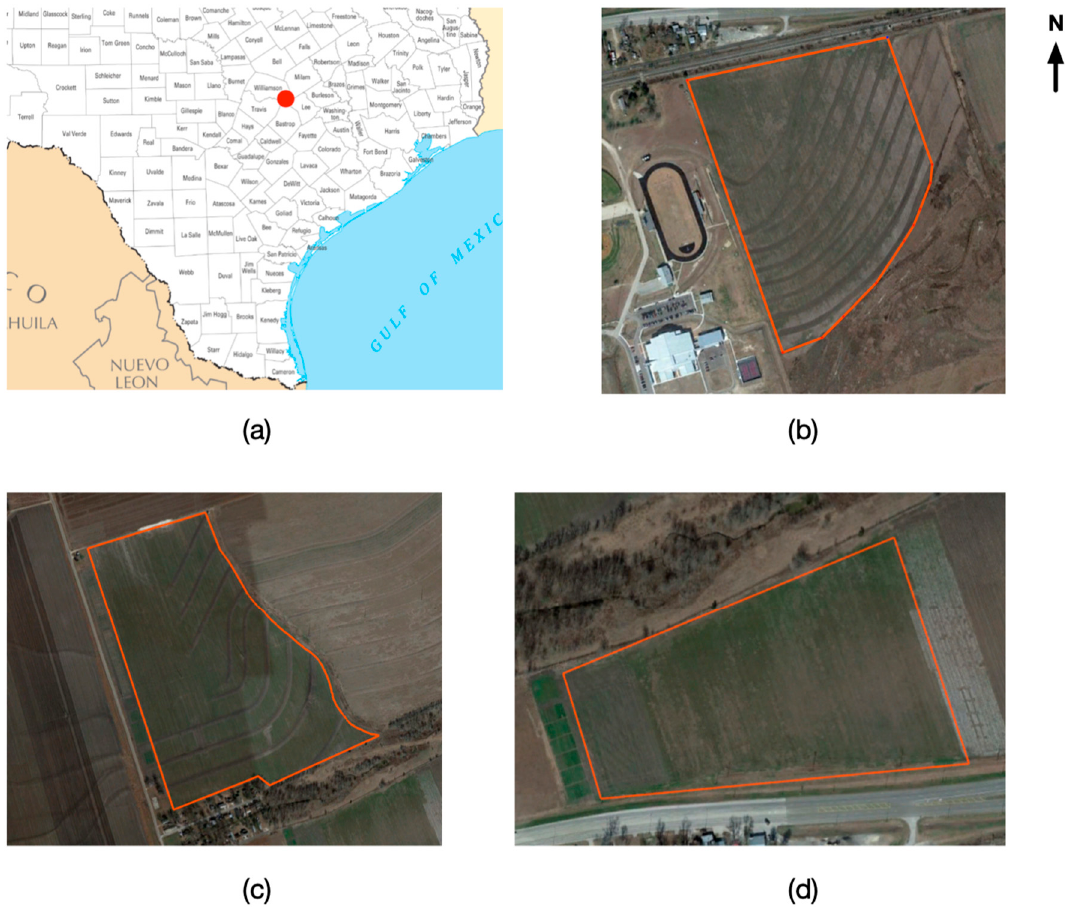
Figure 1. The study was conducted at ( a ) a farm in Williamson County, Texas; ( b ) the Chase field (CH for short) (Scale 1:10000); ( c ) the West Poncho field (WP for short) (Scale 1:15000); and ( d ) the School House field (SH for short) (Scale 1:6000).